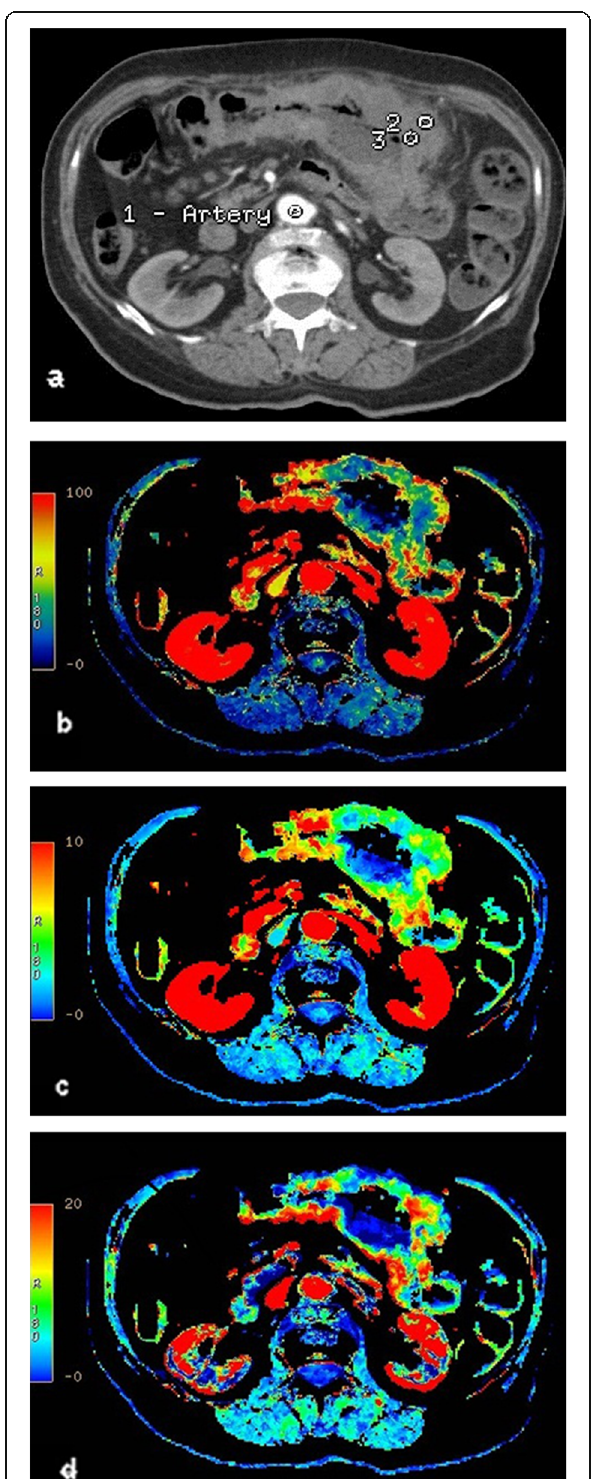
Fig. 1 A 42-year-old man with poorly differentiated cancer of the transverse colon. a Morphologic CT image, demonstrated the position of each ROI, ROI 1 = 20 mm 2 in the artery, ROI 2 = 30 mm 2 at the tumor edge, ROI 3 = 30 mm 2 at the tumor